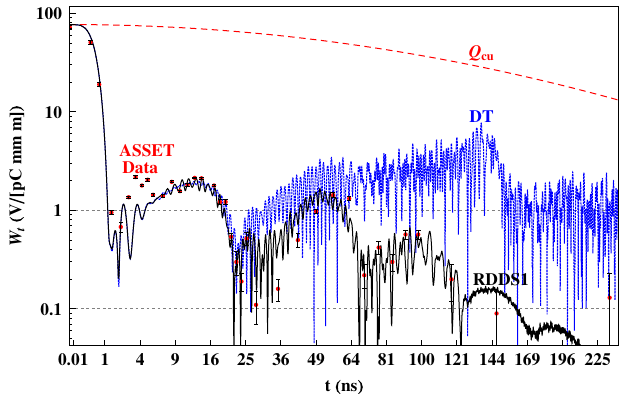
FIG. 12. (Color) Envelope of transverse wakefield for RDDS1 due to frequency errors obtained in fabricating a complete 206 cell structure [22]. The predicted wakefield is indicated by the solid black line and the red dots correspond to experimentally determined values. The design goal of 1 V = ð pC mm m Þ and the limit in the accuracy of the measurement of 0 : 1 V = ð pC mm m Þ are indicated by horizontal dashed